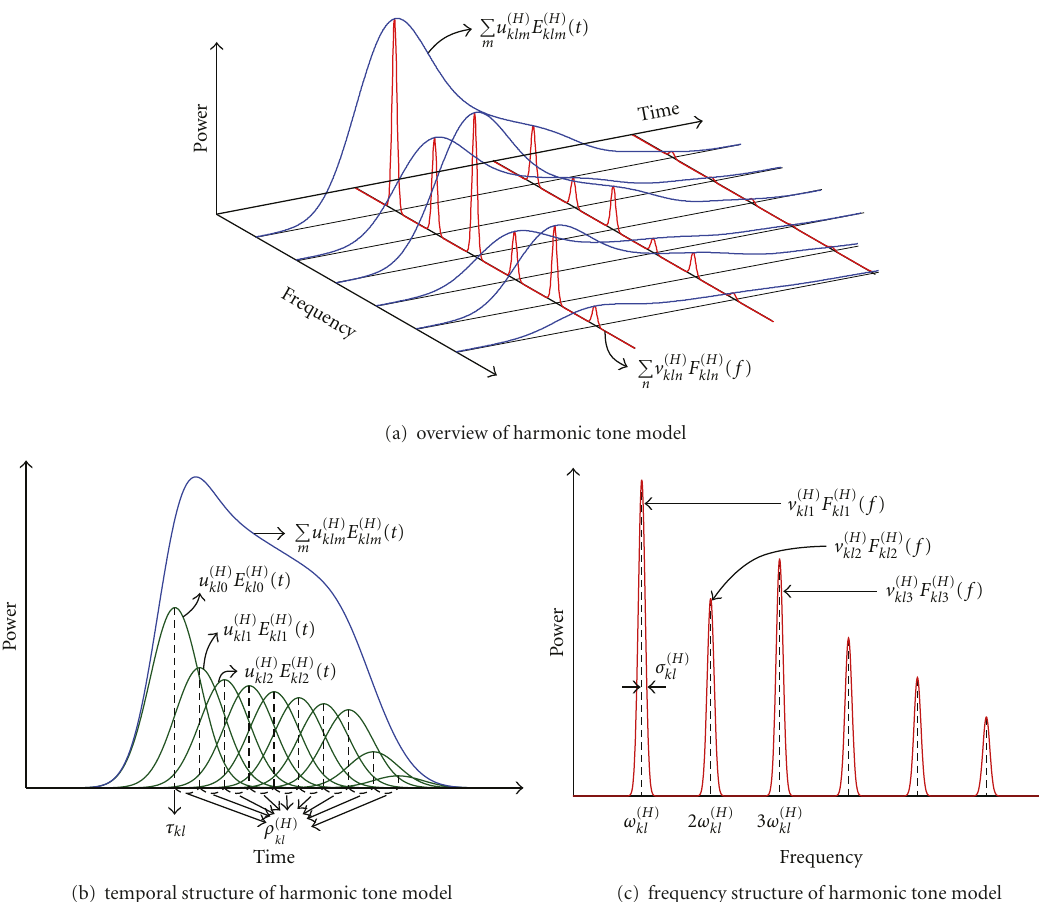
Figure 4: Overall, temporal, and frequency structures of the harmonic tone model. This model consists of a two-dimensional Gaussian Mixture Model, and it is factorized into a pair of one-dimensional GMMs.